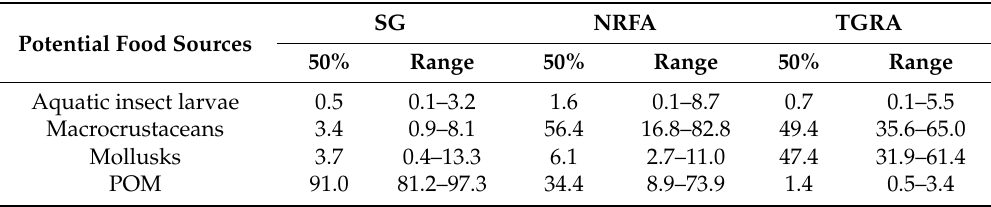
Table 4. Percentages of potential food contributions (50% quantiles, range = 95% Bayesian credible intervals) in three sampling sites for Coreius guichenoti estimated using